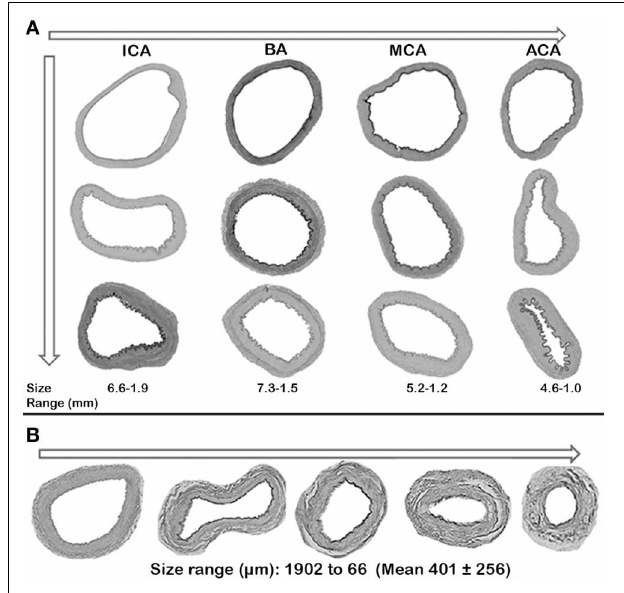
FIGURE 2 | Relationship between arterial size and wall-to-lumen ratio. (A) Large arteries, largest to smallest. (B) Penetrating arteries, largest to